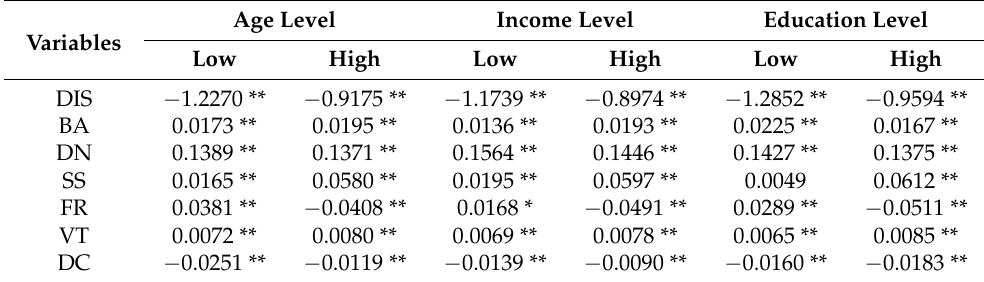
Table 4. The coefficients of subgroup-specific Huff